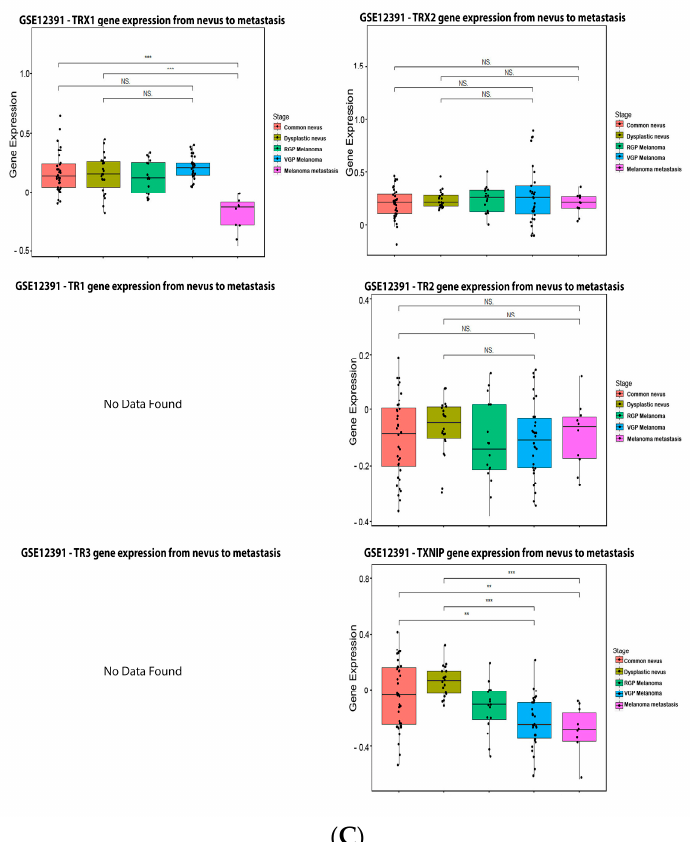
Figure 6. Thioredoxins, thioredoxins reductase and thioredoxin interacting protein on melanoma. ( A ) Percentage of patients with altered genes and types of genetic alterations; ( B ) overall patient survival status, and ( C ) expression in melanoma progression. Red boxes represent the common nevus, yellow boxes the dysplastic nevus, green boxes the radial growth phase (RGP) melanoma, blue boxes the vertical growth phase (VGP) melanoma, and purple boxes the metastatic melanoma. The statistical analysis was performed by ANOVA followed by Tukey test, *** p < 0.001, ** p < 0.01, * p < 0.05 when compared to common or dysplastic nevus. NS: Not